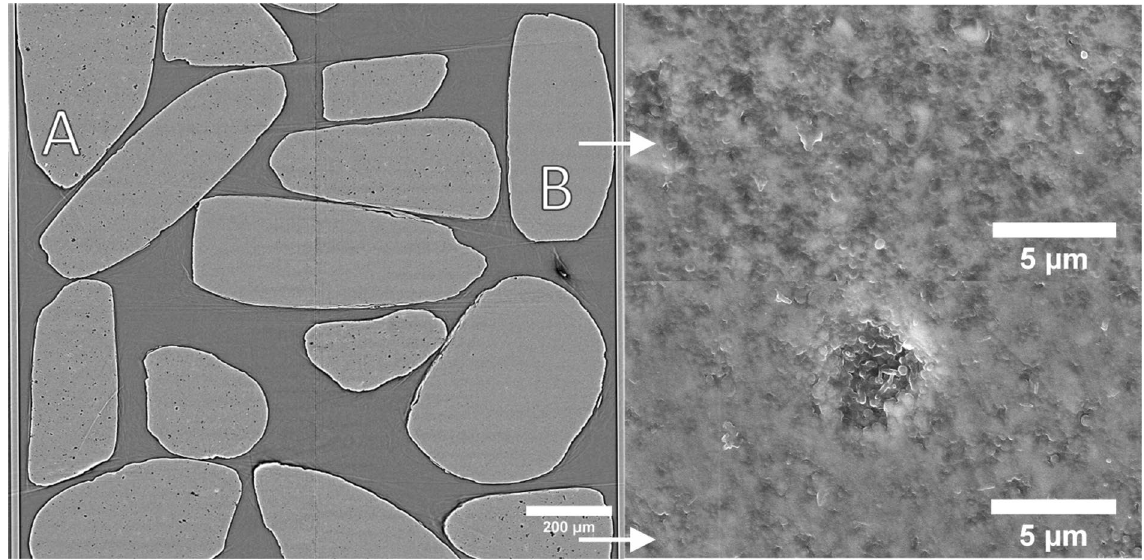
Figure 6. Left: cross-section through the high-resolution tomogram of the mixed particle dataset (voxel size of 0.65 3 µm 3 ). In some of the particles larger pores are visible (marked with A) whereas other particles show less or no pores at all (marked with B). Right: the white arrows point to scanning electron microscopy images of the source material with nominal pore sizes of 50 nm (top) and 150 nm (bottom). These nominal pore sizes are determined by mercury intrusion porosimetry and correspond to pore throat